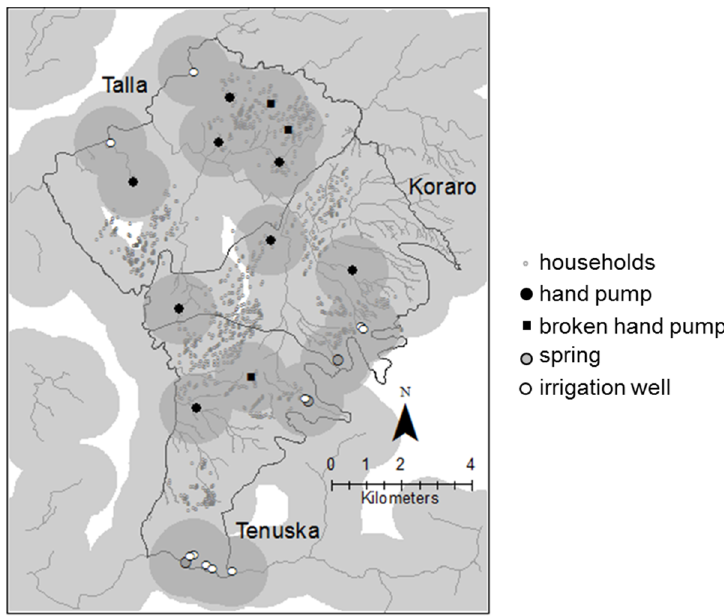
Figure 9. One thousand-meter buffer area on all sources and riverbeds in the research area (buffer area shown in grey).